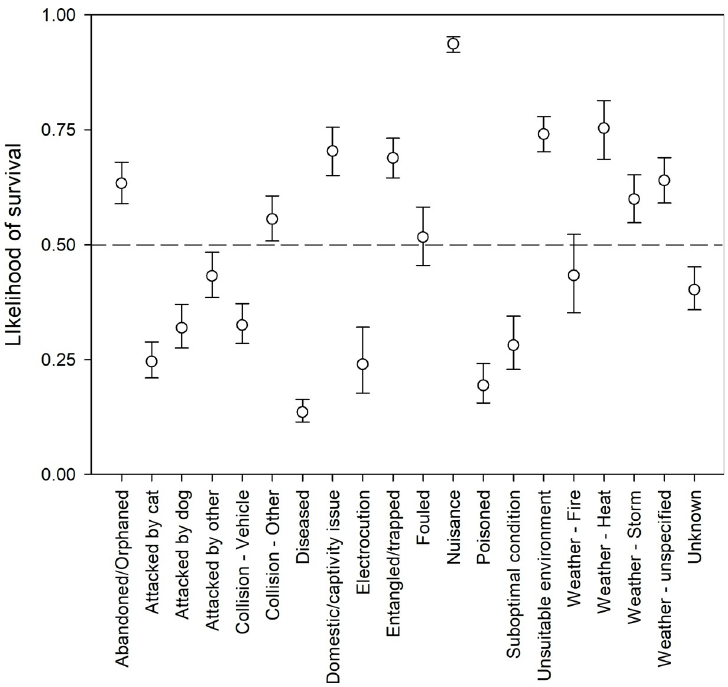
Fig 10. Likelihood of survival + 95% confidence intervals for birds and mammals when averaged, for each cause for rescue.